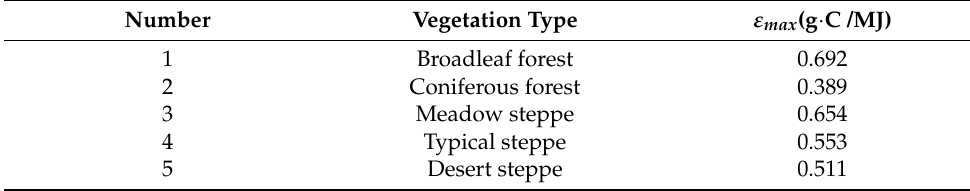
Table 2. ε max of different vegetation